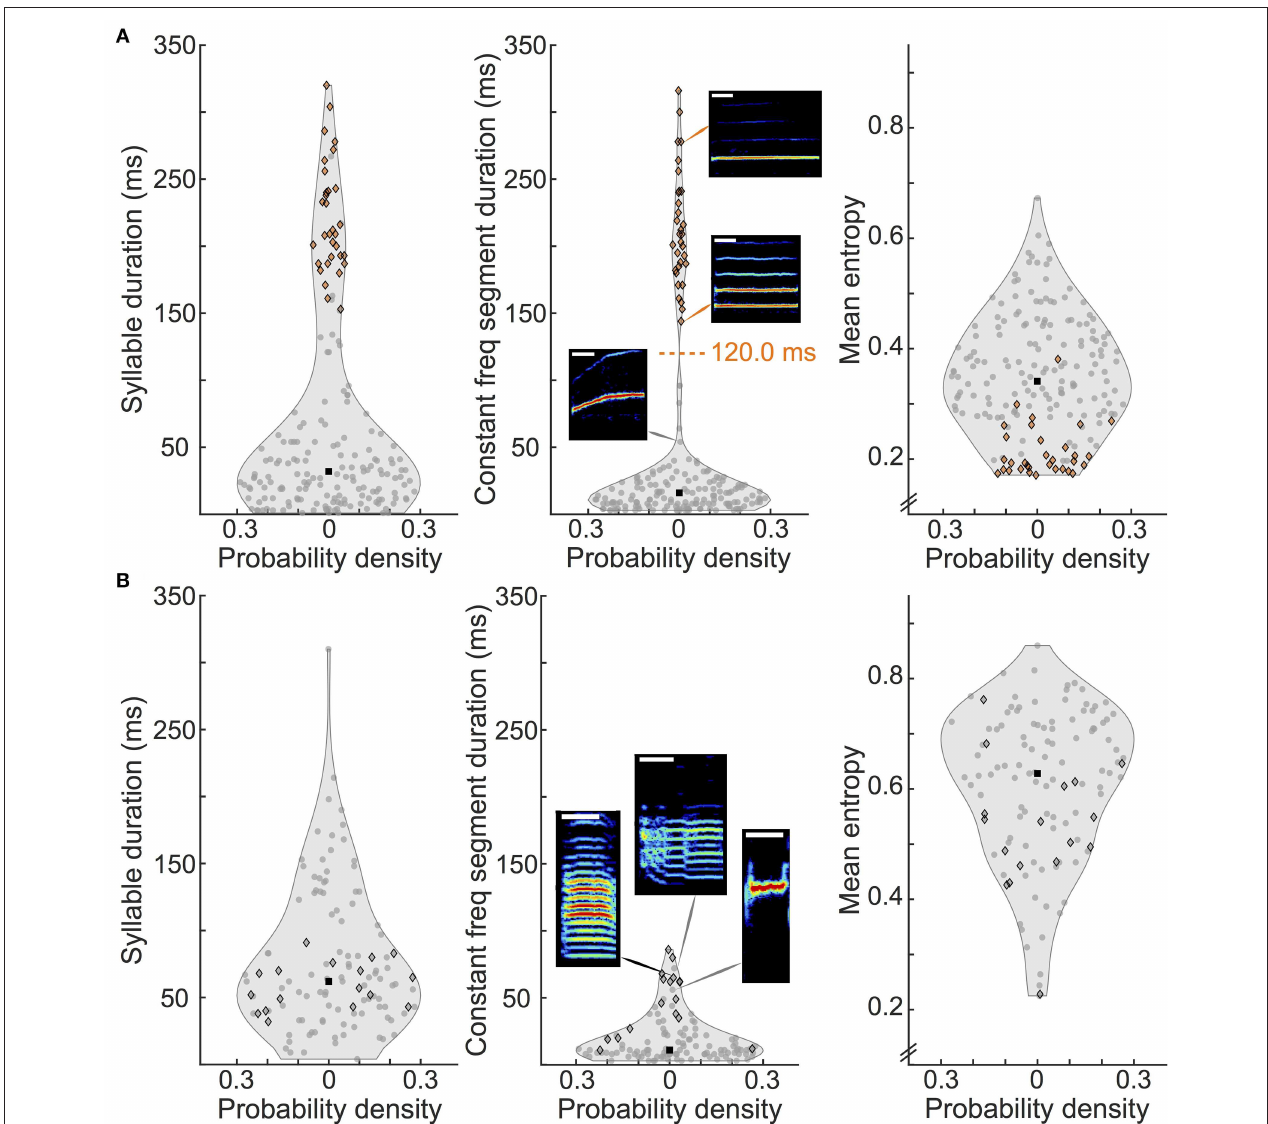
FIGURE 3 | Distribution of spectrogram metrics of canary and zebra finch syllables. (A) Violin plots showing the distributions of syllable duration (left panel), duration of constant frequency segment (middle panel) and mean entropy (right panel) for canary syllables. The gray area represents the distribution density (symmetrically plotted on the x-axis) and its median is shown with a black square. One hundred and eighty seven canary syllables total, bin sizes are 30, 10, and 50ms for each metric respectively. A scatter graph with the y-value of each individual syllable is overlaid on each distribution plot. Scatter points are orange if the syllable contains a constant frequency segment duration larger than the threshold value (120ms) indicated with a dashed line in the middle panel, and gray otherwise. Syllables of a categorized type are outlined with a black diamond (whistles in canaries and harmonic stacks in zebra finches). Note that all syllables that surpass the threshold are whistles. Constant segment duration ranges from 3 to 96ms and 144 to 316ms. Spectrogram insets show example syllables (see text). Height of spectrograms is 10kHz. White bar indicates 50ms. (B) Same as in (A) , for zebra finches, 119 syllables total and same bin sizes per metric. Constant segment duration range: 3–86ms. Harmonic stacks are not isolated in any of the metrics